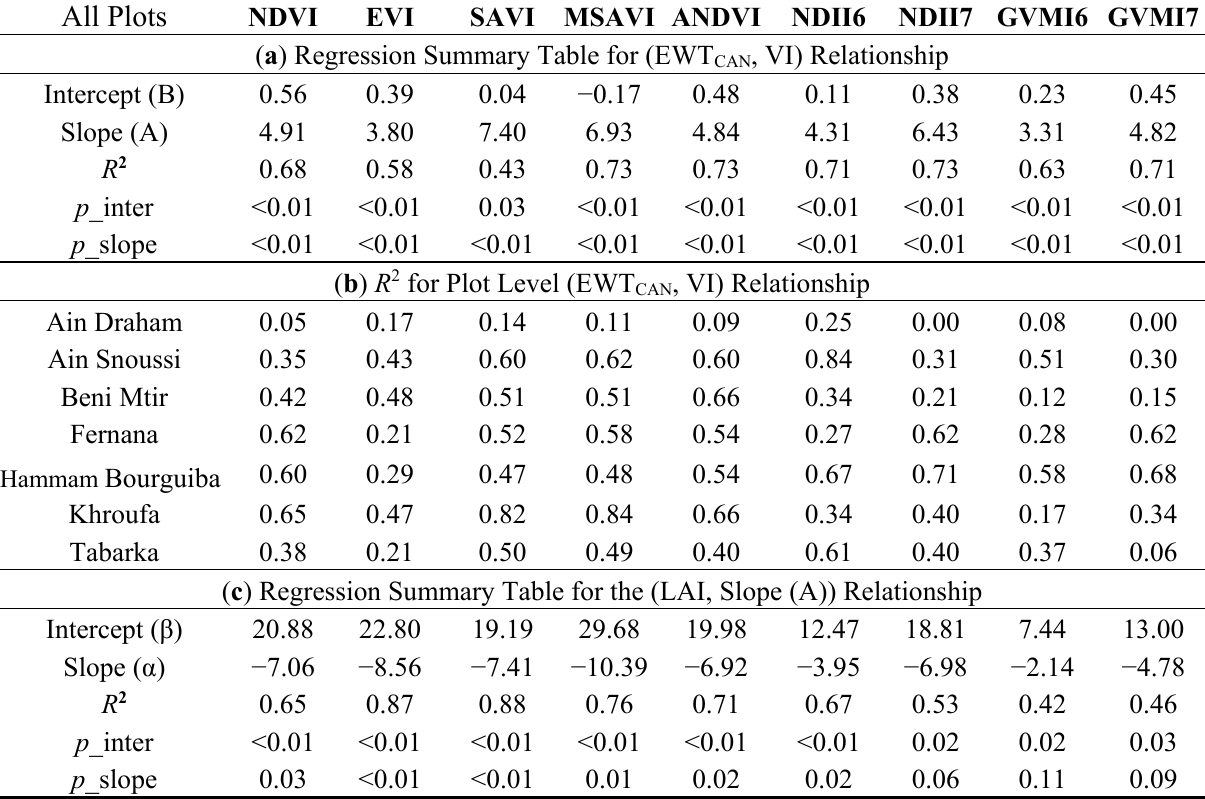
Table 4. ( a ) Regression of linear relation (EWT CAN , VI) by plot; ( b ) regression of linear relation (EWT CAN , VI) for all plots; ( c ) regression between LAI and Slope (A) for all plots. p _inter and p _slope are p -values of intercept and slope.